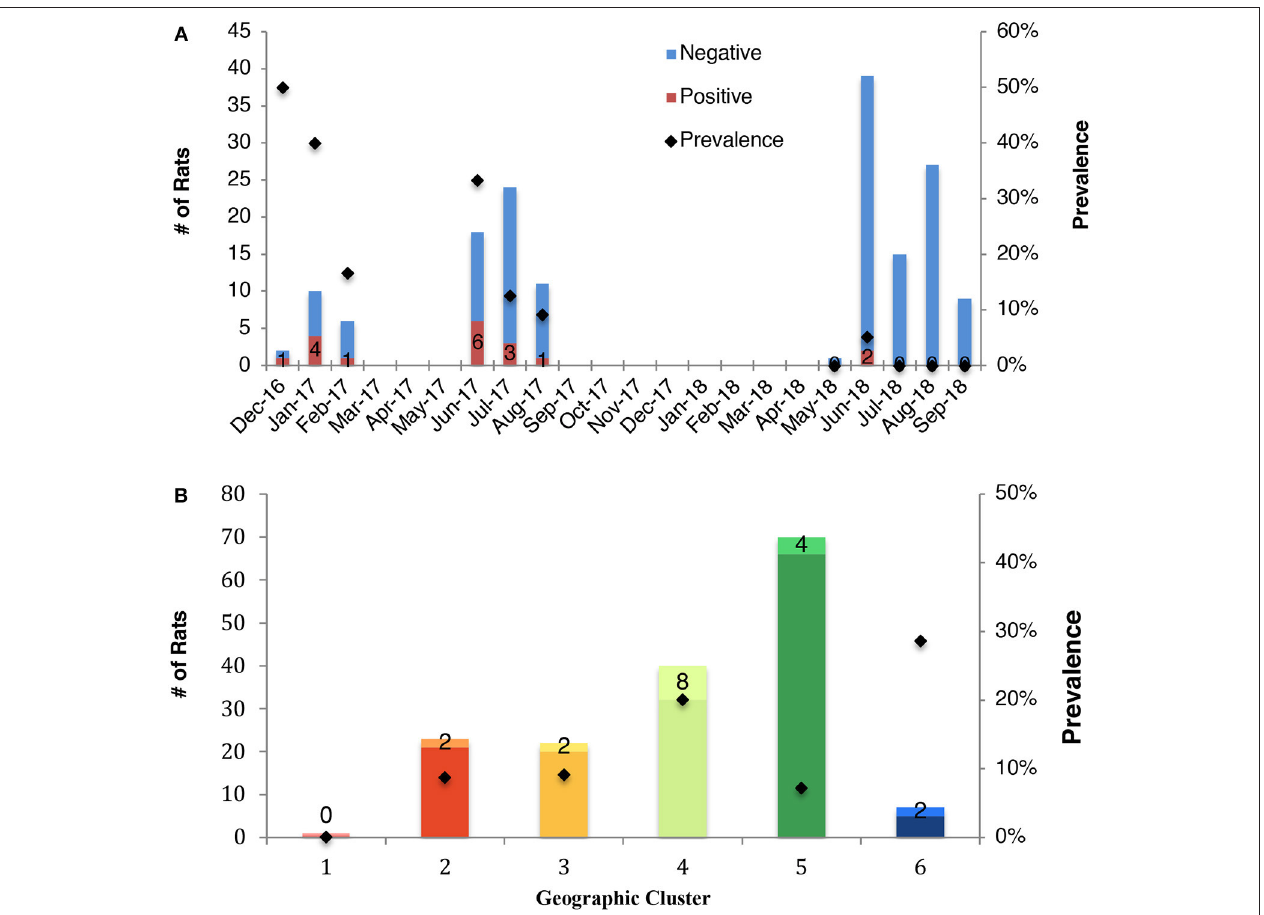
FIGURE 2 | Prevalence of influenza A virus in rats according to (A) month of sampling (all months, including those eliminated from statistical analysis are shown), and (B) geocluster within the City of Boston. The total sampling effort is shown by the vertical bars. Prevalence is indicated by black marker and the number of positive rats is